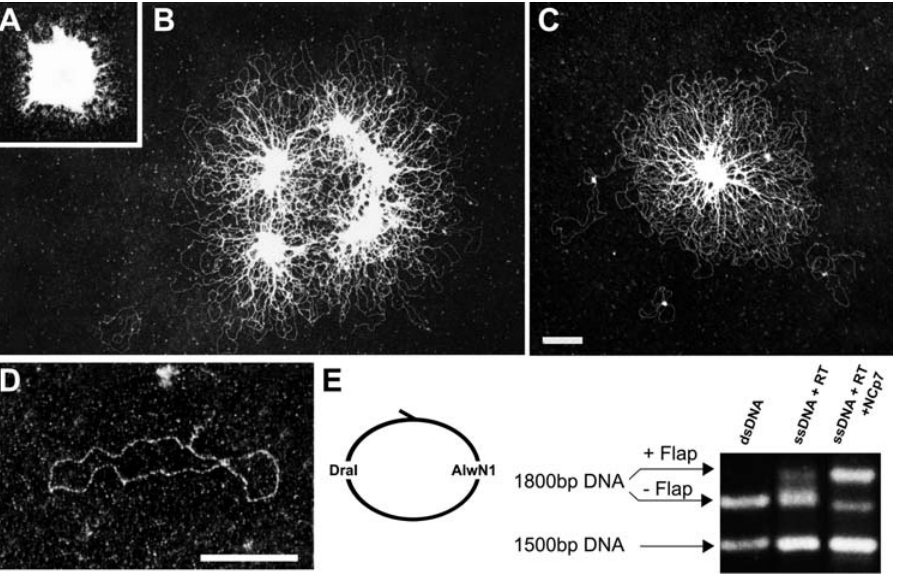
Figure 4. Extrusion of dsDNA produced by RT from ssDNA-NCp7 co-aggregates. Progression of DNA synthesis analyzed by TEM after 2 min. (A), 10 min. (B) and 40 min. (C) from reactions with ssDNA (5 nM), RT (50 nM) and NCp7 (3.4 m M). Disaggregation after 10 min. (B) appeared both at the periphery and within the aggregates. A few individual molecules were visible close to the aggregate after 40 min. (C). (D) A typical DNA product visualized by TEM after 40 min. of DNA synthesis with subsequent incubation for 15 min. at 70 u C in the presence of 0.4 M NaCl. (E) Band shift analysis of DNA flap synthesis within the dsDNA produced by RT after 40 min. at 37 u C with 50 nM RT, with or without 3.4 m M NCp7. An excess of DraI and AlwnI enzymes that digest this dsDNA into two fragments (1800 and 1500 bp) was added. The DraI-AlwnI digestion products of the plasmid DNA are shown as a control on the left. When the HIV-1 central DNA flap is fully synthesized (i. e. with NCp7), the 1800 bp fragment is shifted to a slower migrating band. Magnification is identical for panels A,B,C. The scale bars correspond to 250